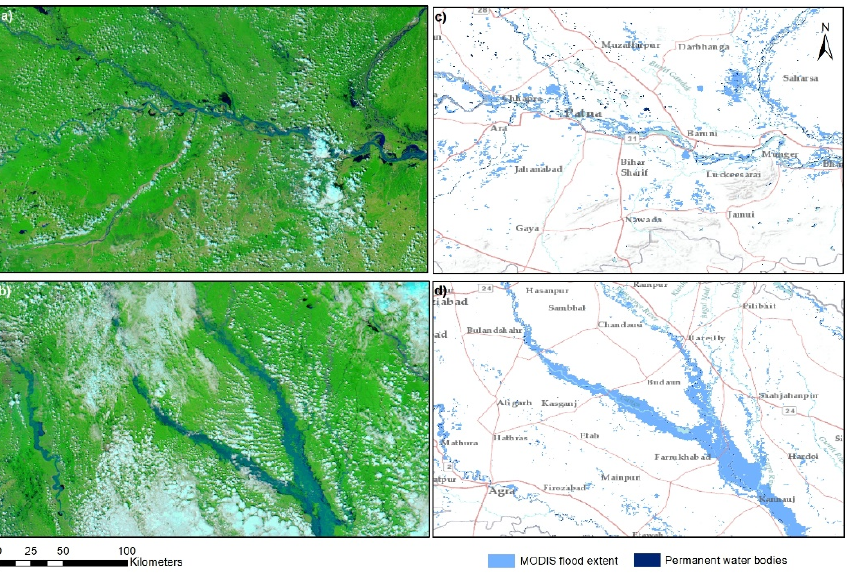
Figure 3. ( a , b ) MODIS TERRA satellite data taken on 22 September 2010; ( c , d ) are the flood inundation extent covering the states of Uttar Pradesh and Bihar, India. Source: IWMI.